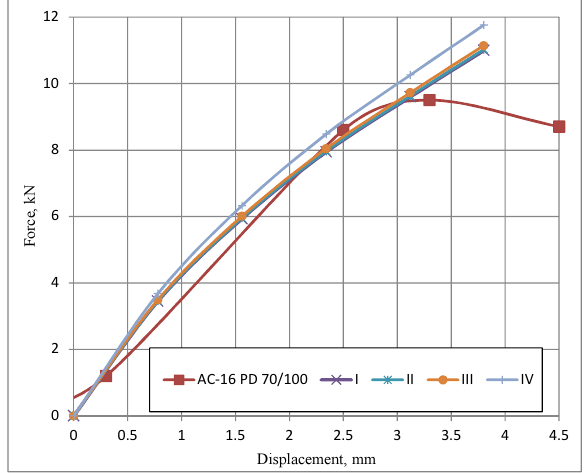
Fig. 12. Influence of the matrix film on force reaction of the DE model with comparison to real test data, where: I – no matrix